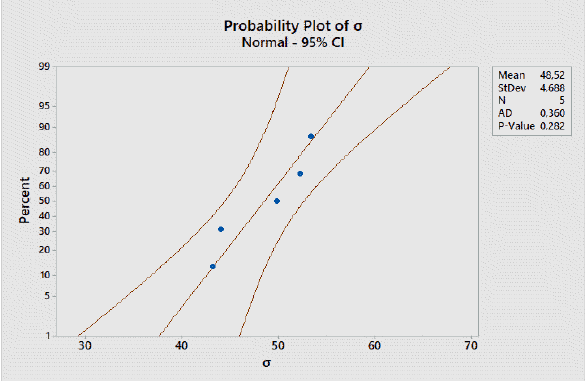
Figure 14: Comparison between the flexural moduli of elasticity [ N / m 2 ] for the four specimen types.